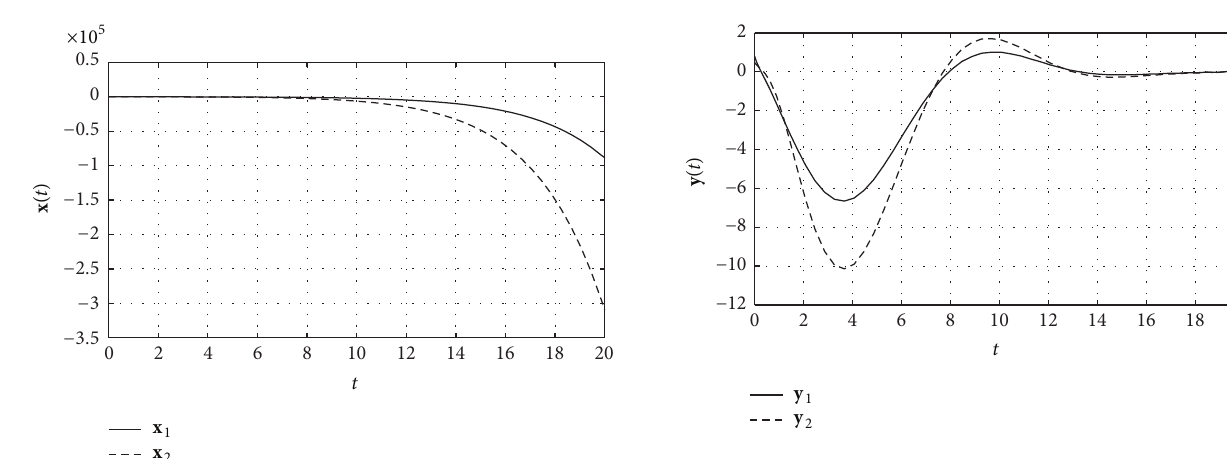
Figure 3: The trajectories of closed-loop controlled system output y (𝑡) .